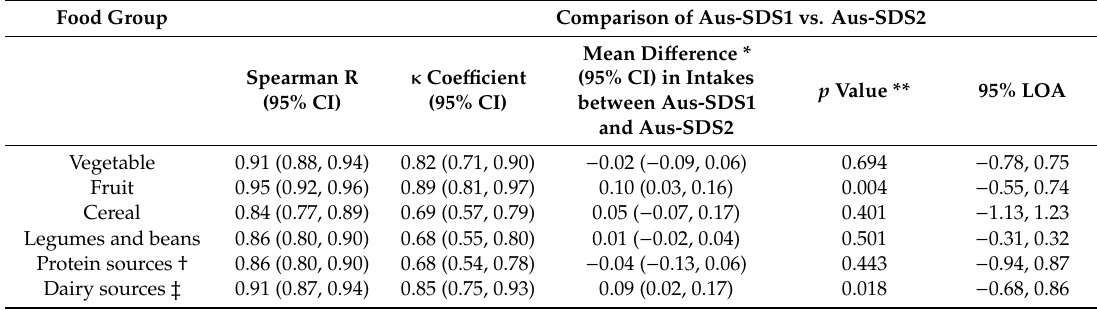
Table 4. Reproducibility of Aus-SDS determined by comparison of core food group intake (serves / day) between Aus-SDS1 and